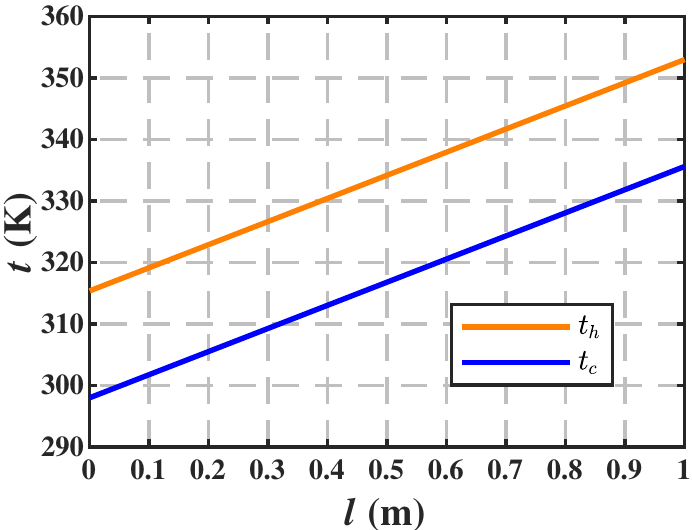
Figure 3. Temperature profiles of the demonstrated CFHX with same heat capacity